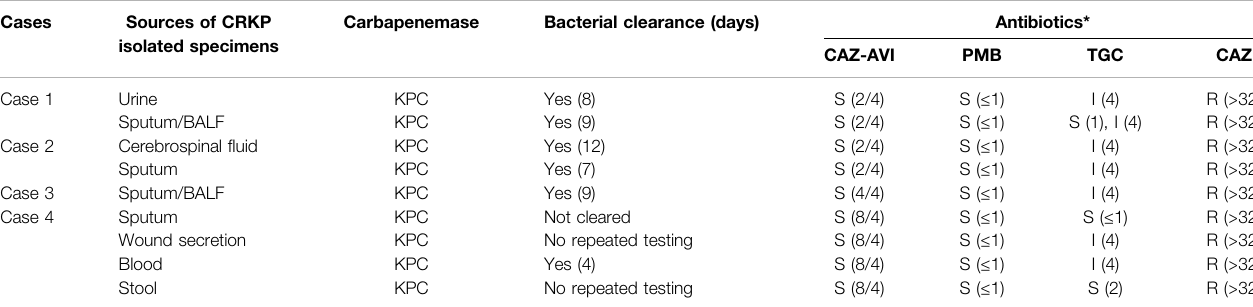
TABLE 2 | In vitro susceptibility of CRKP to the tested antibiotics (with MICs in μ g/mL given in parentheses) and bacterial